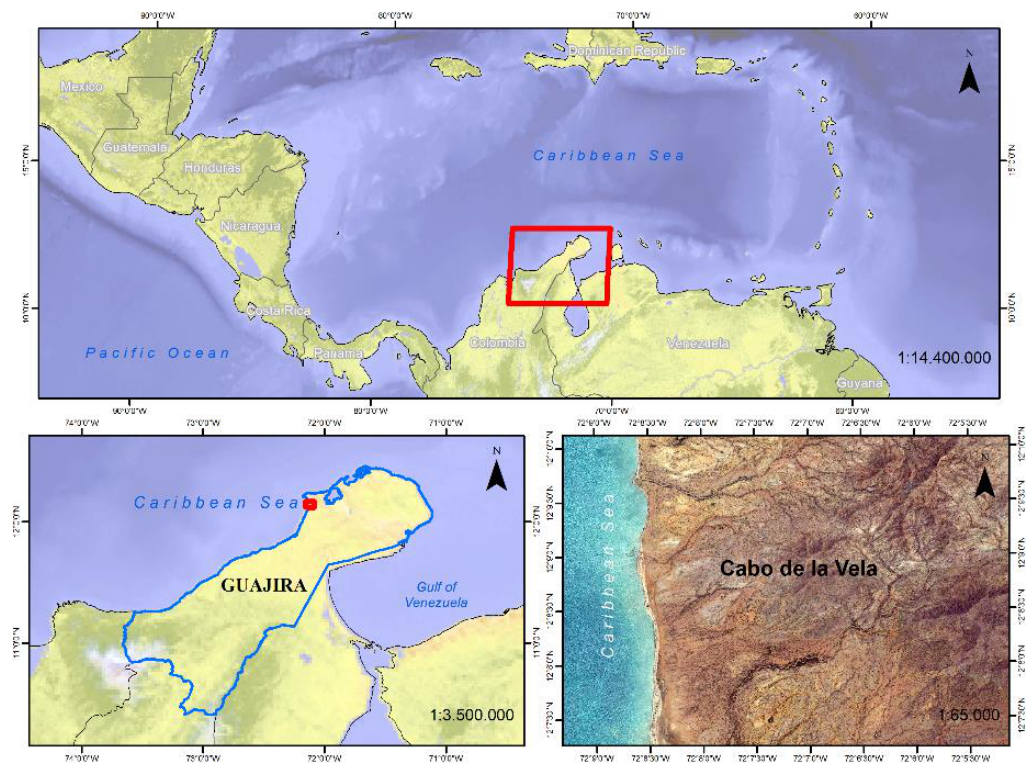
Figure 2. Location of study area, Cabo de la Vela, La Guajira.